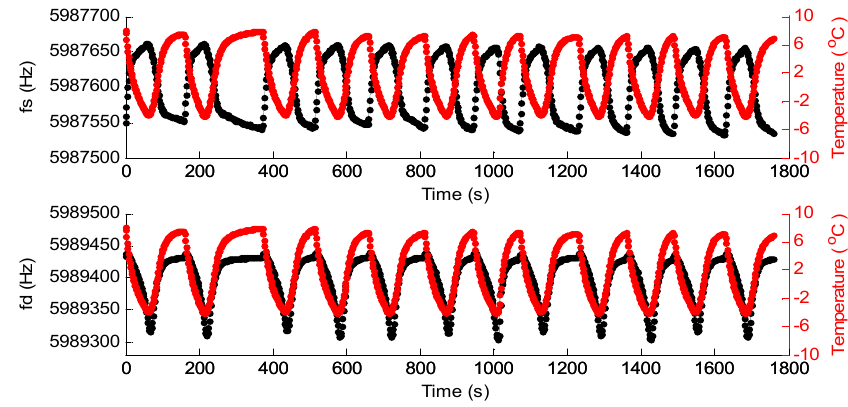
Figure 7. The frequencies of the DQCM with the change in temperature.